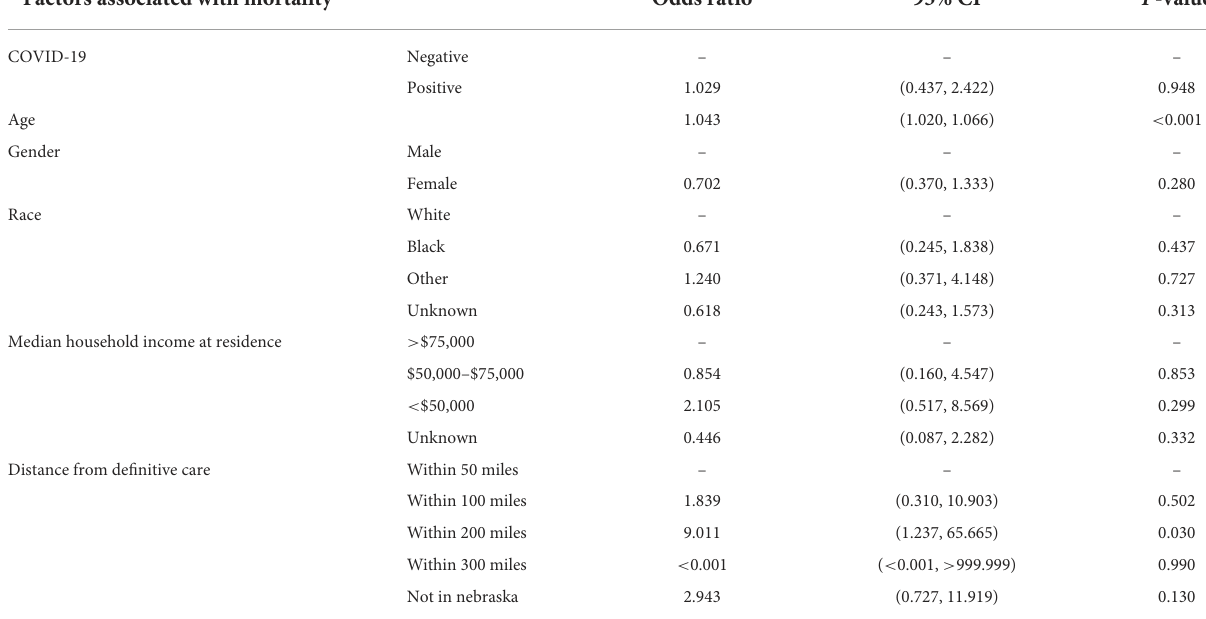
TABLE 2 Multivariate logistic regression factors associated with mortality among patients at Nebraska Medicine between April and October 2020, Omaha, Nebraska. Factors associated with mortality Odds ratio 95% CI